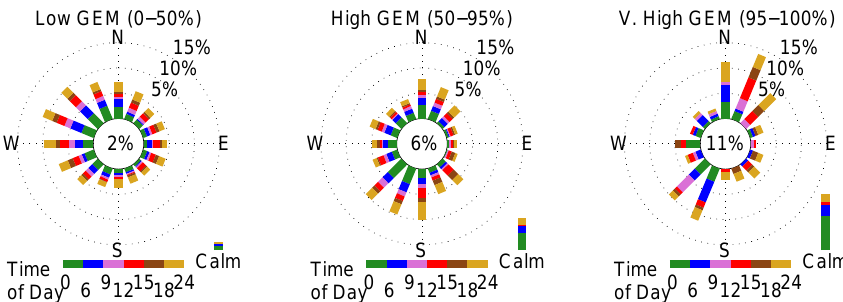
Fig. 5. Wind roses separated according to concentrations of gaseous elemental mercury. Left: 1780h with concentrations in the bottom 50%, middle: 1636h with concentration in the 50 to 95% interval and right: 179h with concentrations in the top 5%. The dominant wind direction for low values is from the northwest, for high values it is from the south/southwest and from the north, and for the highest peaks it is from the northeast and from the southwest. Percentage of hours with calm winds shown in the middle circle.